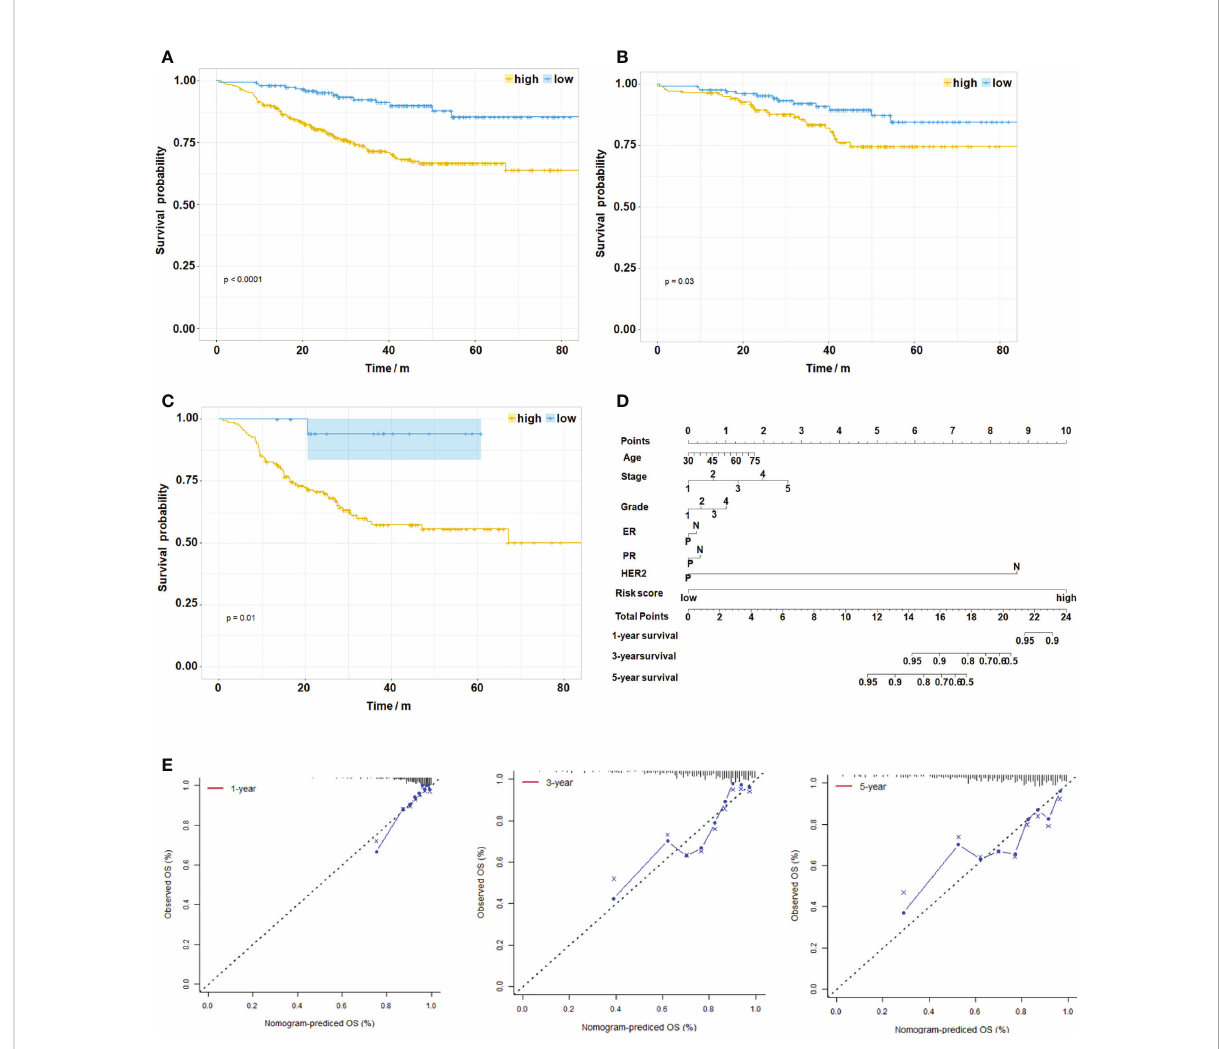
FIGURE 6 Evaluation of the Risk Score on Prognosis of Breast Cancer. (A) Kaplan – Meier survival analysis of the different patient risk groups of overall breast cancer (high-risk, n=333; low-risk, n=159, P < 0.0001). (B) Kaplan – Meier survival analysis of the different patient risk groups of luminal BC (high-risk, n=139; low-risk, n=135, P=0.03). (C) Kaplan – Meier survival analysis of the different patient risk groups of TNBC (high-risk, n=150; low-risk, n=19, P=0.01). (D) A nomogram for clinical diagnosis was constructed based on clinical characteristics and risk scores. (E) The calibration plots for predicting recurrence at 1, 3, and 5 years. The X-axis represents the predicted recurrence probability from the nomogram, and the y-axis represents the actual recurrence